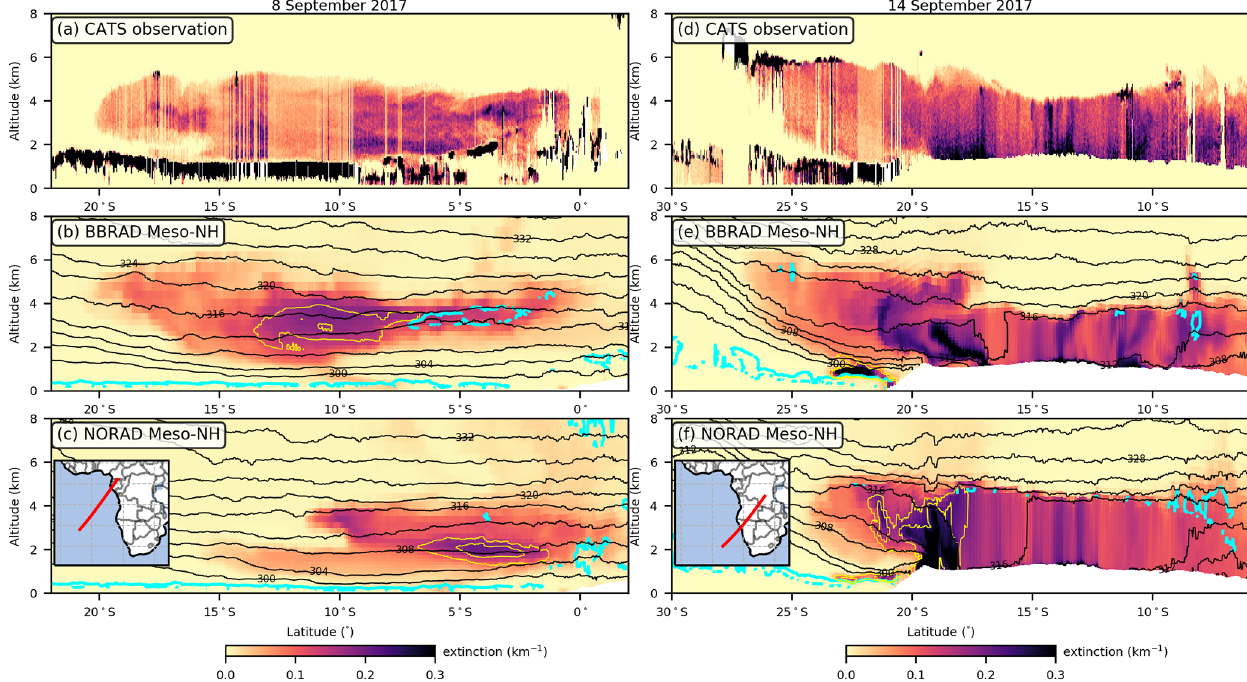
Figure 5. Vertical cross-sections of extinction at 1064nm on (a–c) 8 and (d–f) 14 September 2017 from (a, d) CATS, (b, e) BBRAD and (c, f) NORAD along the red line shown in the inset of the bottom panels. In panels (b) , (c) , (e) and (f) , the black contours show the potential temperature (in K), the cyan contour the cloud fraction at 10%, and the yellow contours the dust extinction at 0.05 and 0.1km − 1 . On 8 September, CATS observations were taken between 22:40 and 22:47UTC, and Meso-NH simulations are at 24:00UTC. On 14 September, CATS observations were taken between 19:02 and 19:11UTC, and Meso-NH simulations are at 24:00UTC. Results are shown for the BBRAD and NORAD members starting at 00:00UTC on 1 September